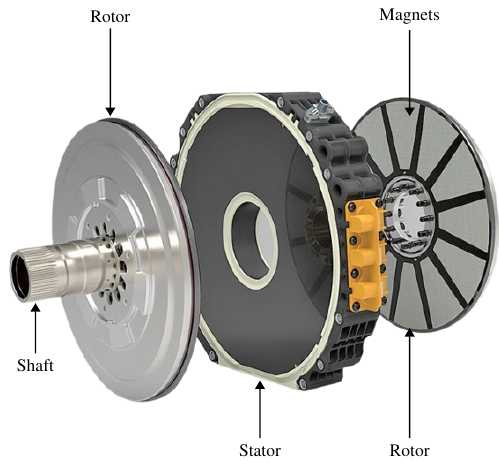
Figure 10. YASA axial flux motor